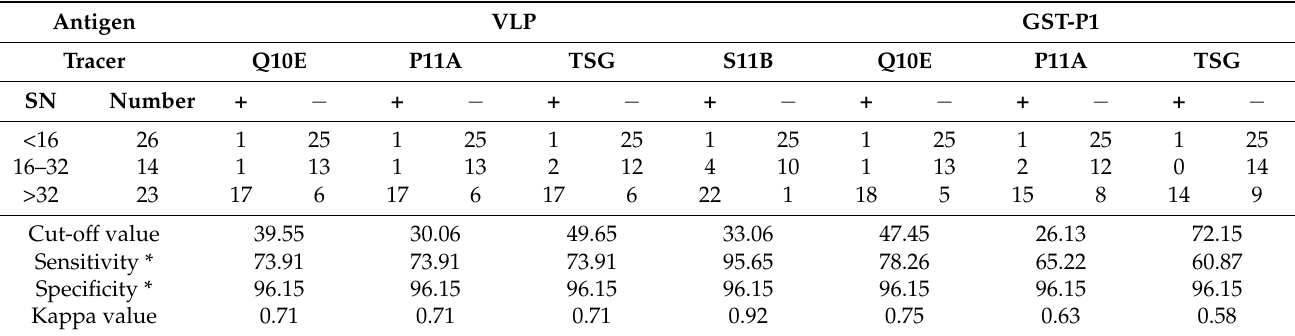
* Samples for SN16–32 were excluded from calculations of sensitivity and